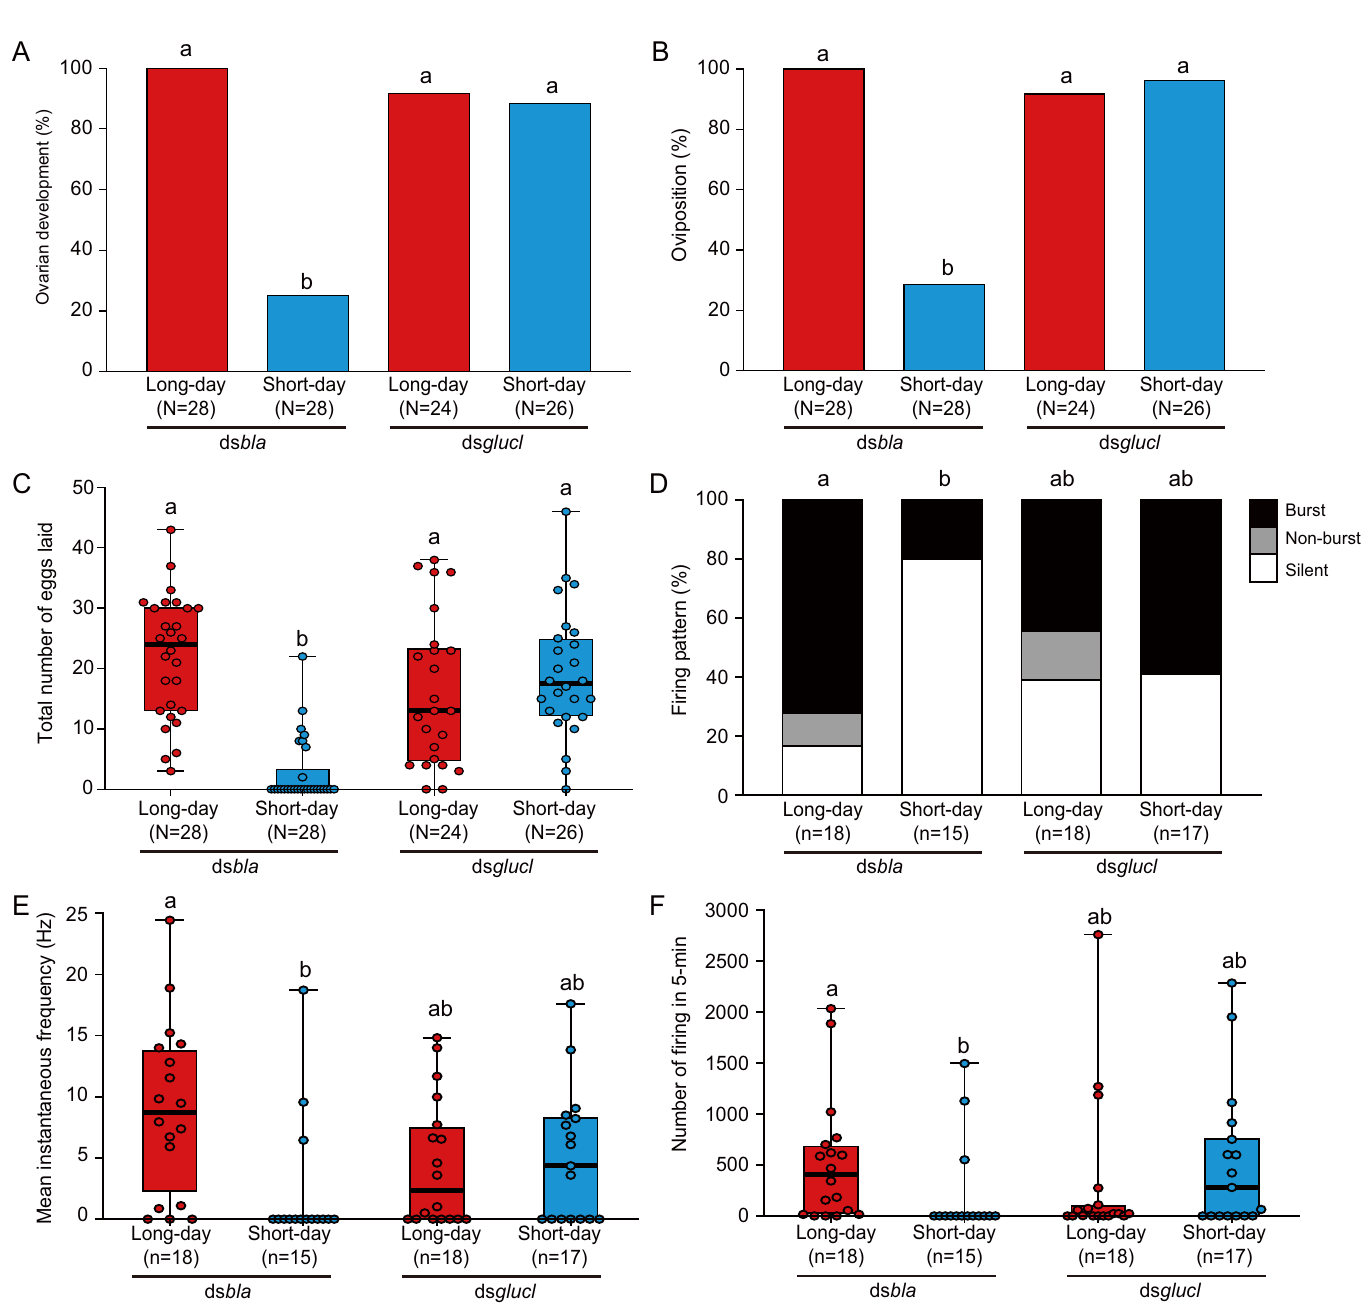
Fig 7. RNAi of glucl disrupts photoperiodic responses in the reproductive phenotypes and PI neuronal activity. (A, B) Columns showing proportions of (A) ovarian development and (B) oviposition of ds bla- and ds glucl -injected females under long-day and short-day conditions. (C) Box and scatter plots showing total number of eggs laid in each group. (D) Columns showing proportions of the 3 firing patterns in ds bla- and ds glucl -injected females under long-day and short-day conditions. (E, F) Box and scatter plots showing the (E) mean instantaneous frequency and (F) number of firing events in 5 min in each group. Columns and box plots with different letters indicate statistically significant differences (A, B, D: Tukey-type multiple comparisons for proportions [D: “silent” rate comparison]; C, E, F: Steel–Dwass test, P < 0.05). (C, E, F) Lines at the top, middle, and bottom of the box plots indicate the upper quartile, median, and lower quartile, respectively. Upper and lower whiskers of the box plots indicate the maximum and minimum values, respectively. The underlying data can be found in the S1 Data datasheet of numerical values for each fig.xlsx. PI, pars intercerebralis; RNAi, RNA